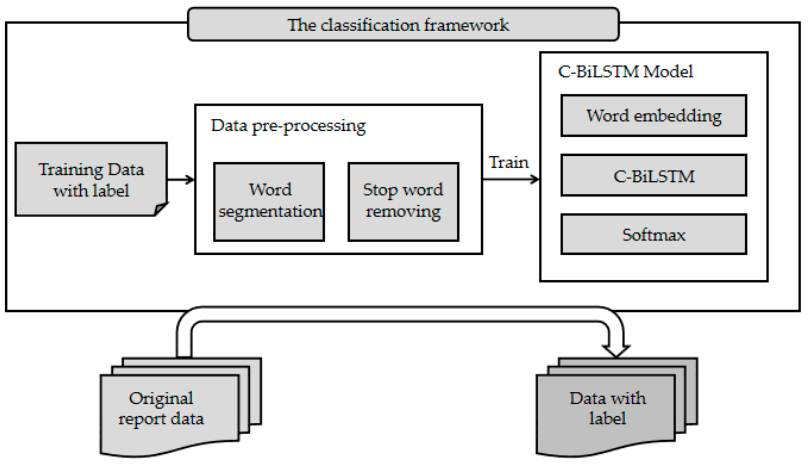
Figure 1. The framework of the convolutional bidirectional long short-term memory (C-BiLSTM)-based classification approach.